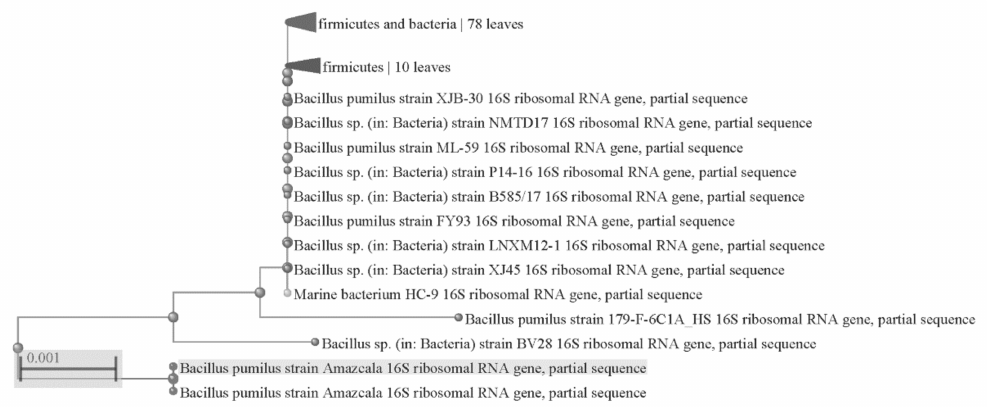
Figure 1. Phylogenetic neighbor-binding tree reconstructed based on the 16S rRNA gene sequence showing the phylogenetic relationship between the isolated B. pumilus strain (MN067217) and similar strains.